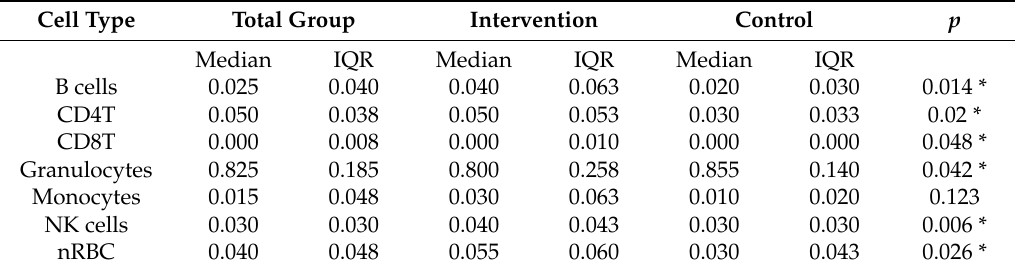
Table 4. Relative proportion of cell types in ROLO cord blood samples ( n =